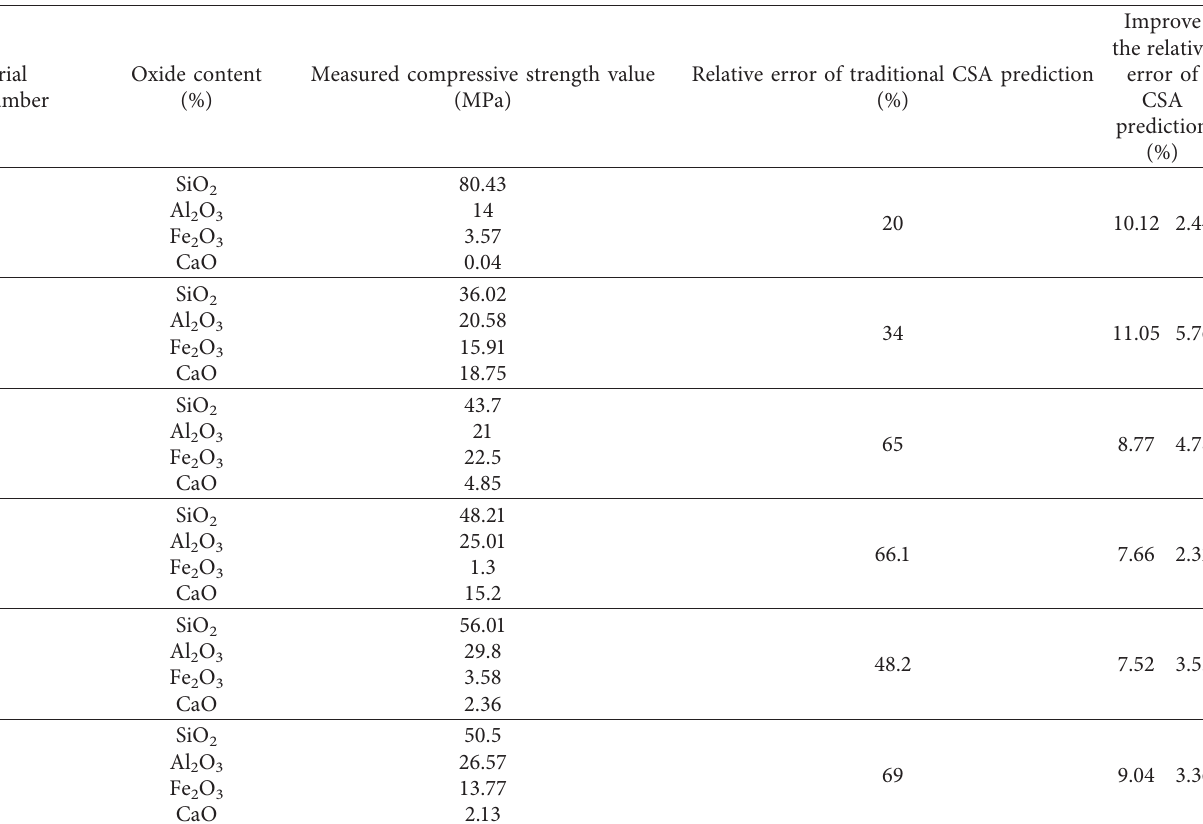
Table 9: Comparison of 28d predictive compressive strength for different oxide proportions.